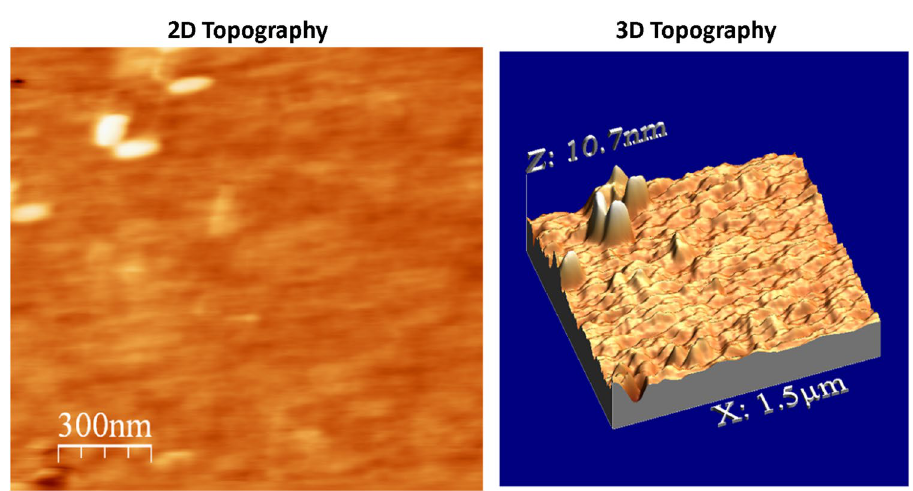
Figure 6. AFM surface studies of the MoS 2 layers.